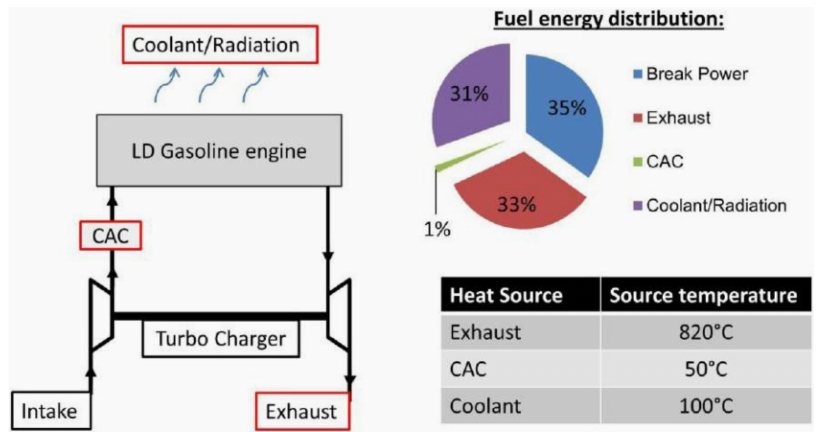
Figure 5. Energy Balance for the 2.0-L Turbocharged Gasoline